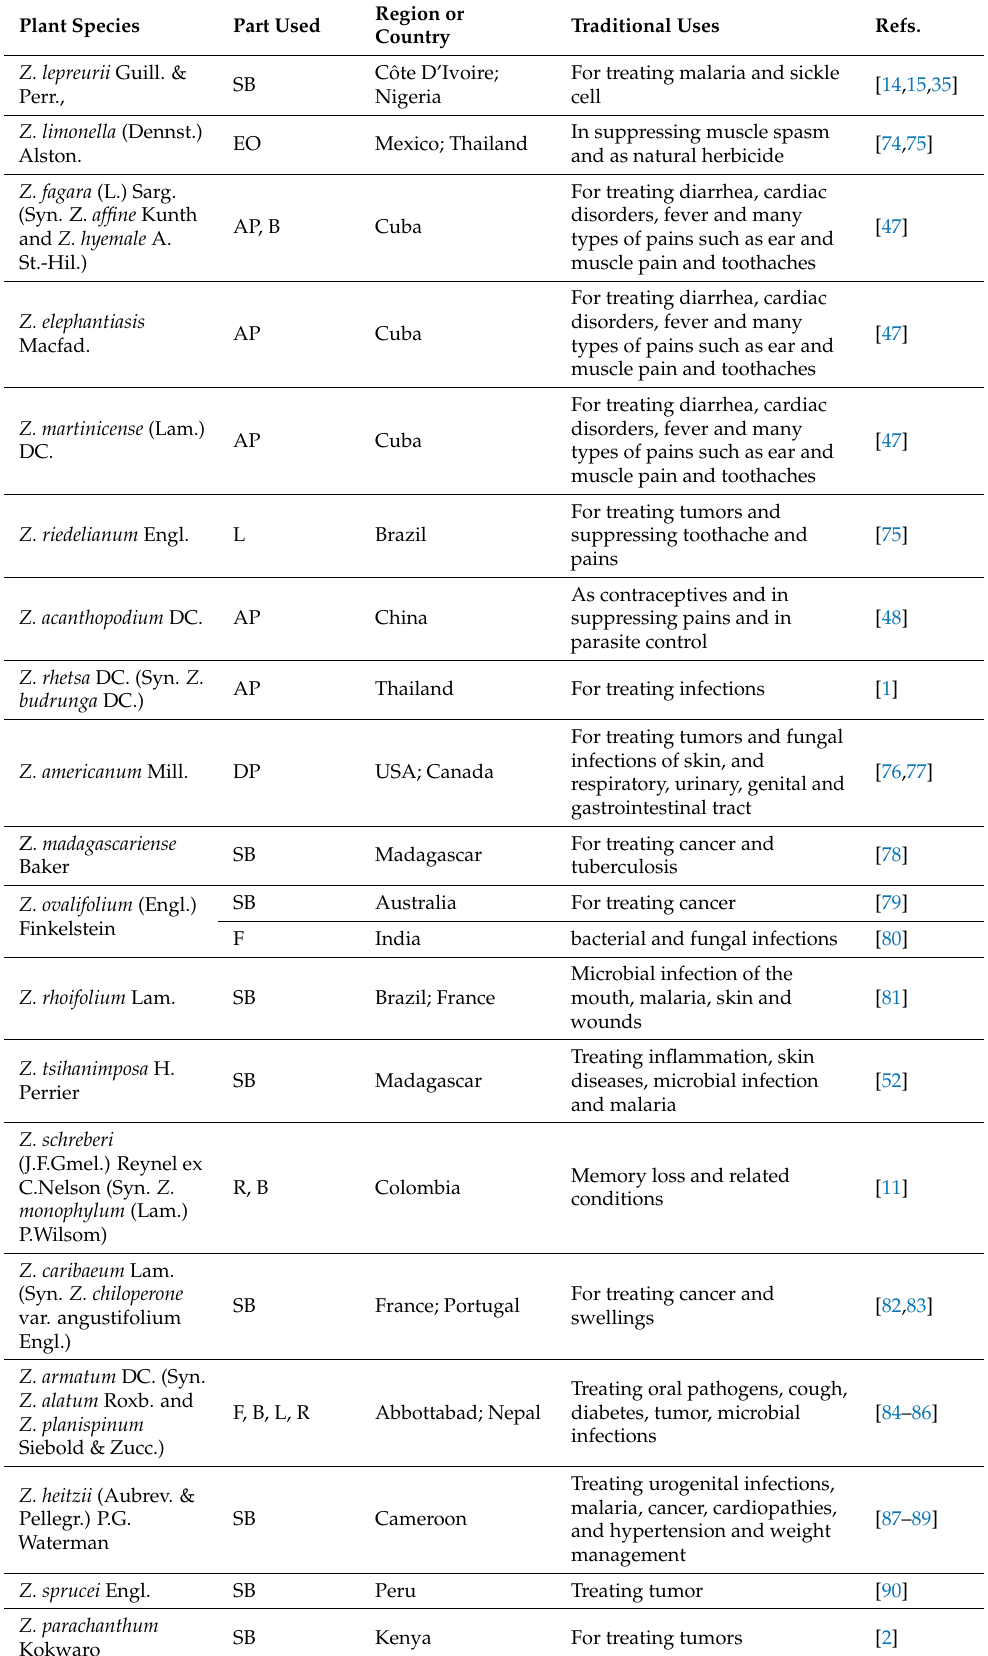
Table 1. Cont. Plant Species Part Used